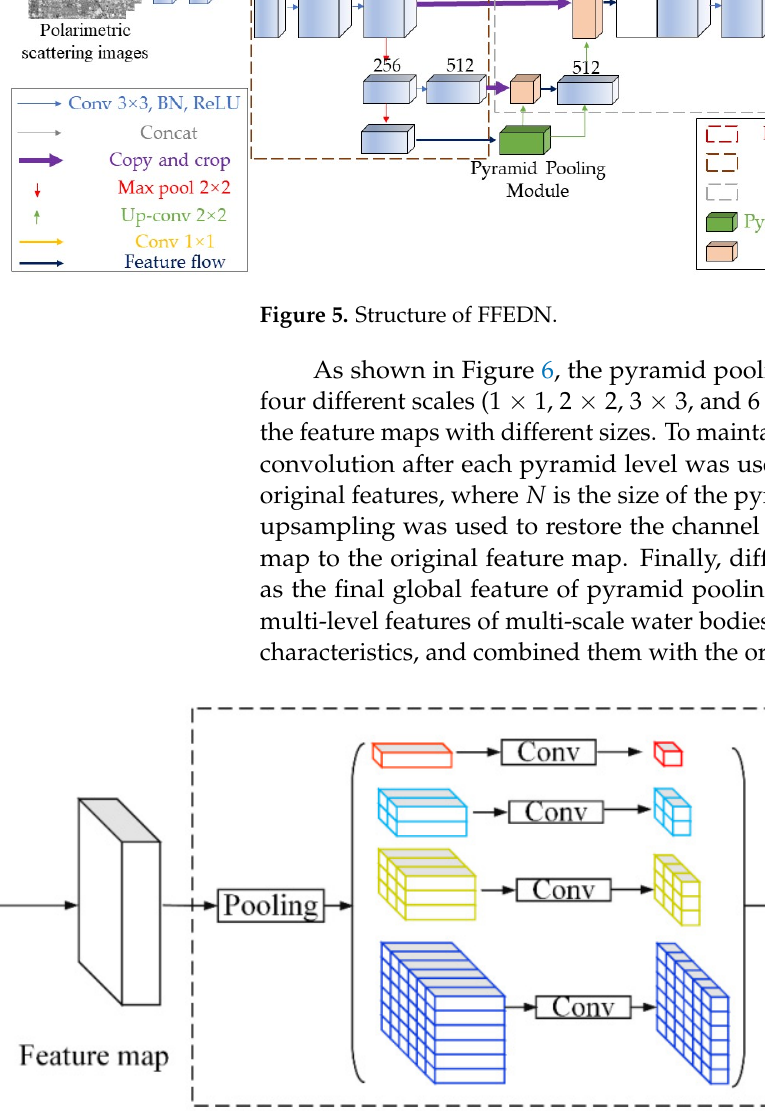
Figure 6. Structure of pyramid pooling module.